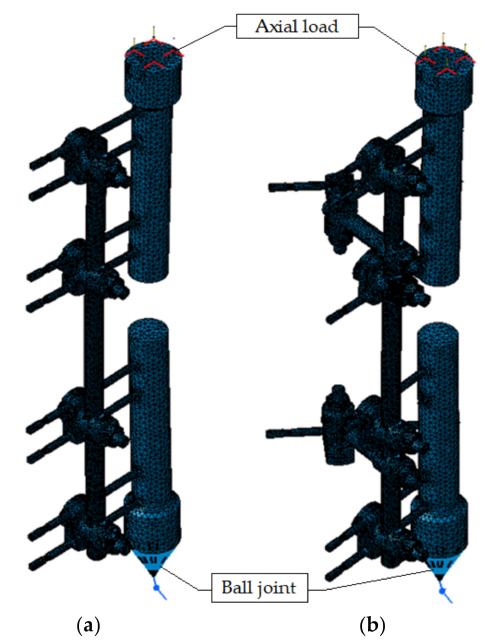
Figure 3. FEM model of the Sarafix device; ( a ) B50 configuration, ( b ) C50